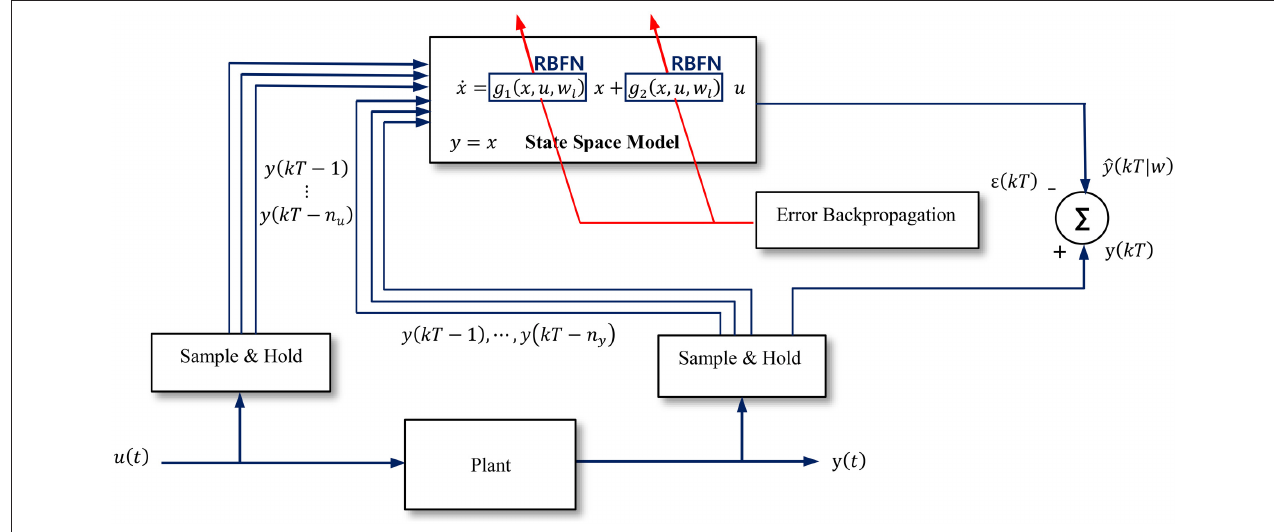
FIGURE 3 | System identification using gray